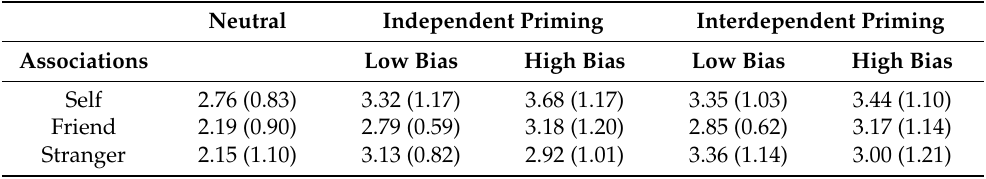
Table 2. Mean d-prime and SDs (in brackets) as a function of association, priming, and bias group in Experiment